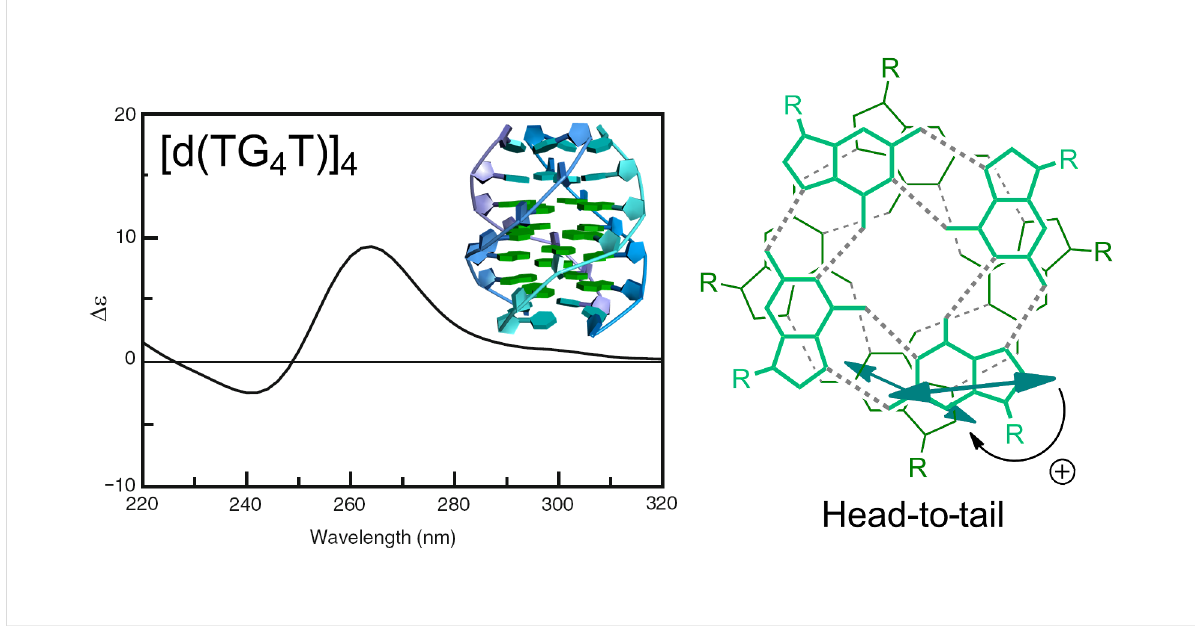
Figure 6: Exciton coupling in the G-quadruplex [d(TG 4 T)] 4 . For this sequence, the quadruplex is formed by four parallel strands and the quartets face each other in a head-to-tail arrangement. Reprinted in parts with permission from [22] to G.P. as an author of the article, copyright 2014, The Royal Society of